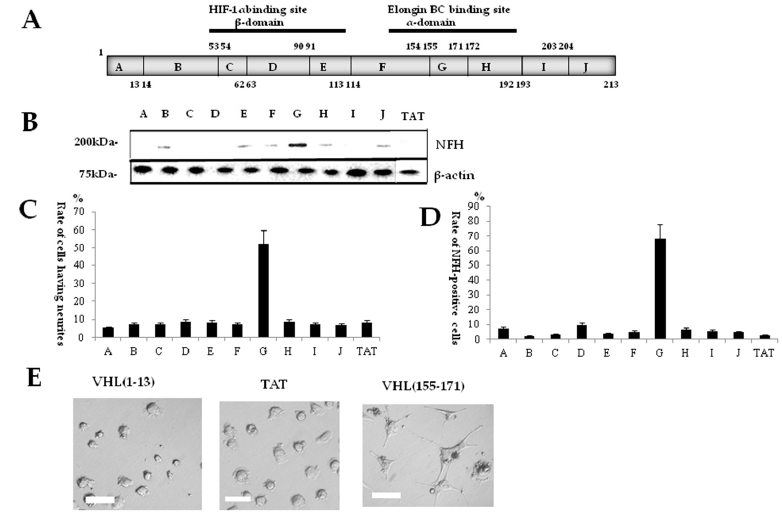
Figure 1. ( A ) Ten divided sequences of von Hippel-Lindau tumor suppressor protein (pVHL) and the relation to the structure of pVHL. The elongin BC binding site exists in α -domain; and the HIF-1 α binding site, in β -domain; ( B ) Immunoblotting study with anti-Neurofilament-H (anti-NFH) antibody. The most potent expression of NFH was obtained with sequence G [VHL(155–171)]; ( C ) Immunocytochemical study with anti-NFH antibody. The greatest rate of immunoreactive cells for NFH was found at the “G” sequence (VHL(155–171)); ( D ) Rates of cells having neurites for the 10 divided sequences. The “G” sequence (VHL(155–171)) shows the greatest rate of cells having neurites. Phase-contrast microphotographs showed cells for “G” sequence (VHL(155–171)) and cells for “A” sequence [VHL(1–13)]; ( E ) The cells for “A” sequence (VHL(1–13)) and the cells for TAT showed no morphological change, as with non-treated cells ( left ), whereas the cells for “G” sequence [VHL(155–171)] assumed a neuron-like morphology ( right ). Scale bar = 20 μ m.